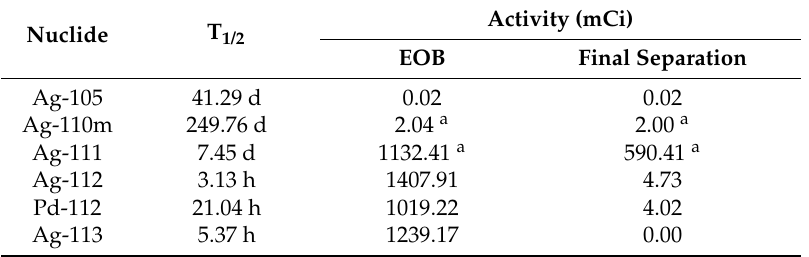
Table 3. Radioactive quantities of silver and palladium isotopes produced in a proton irradiated thorium target produced at the BLIP. Parameters for calculations: a 1 g Thorium-232 target (450 mg